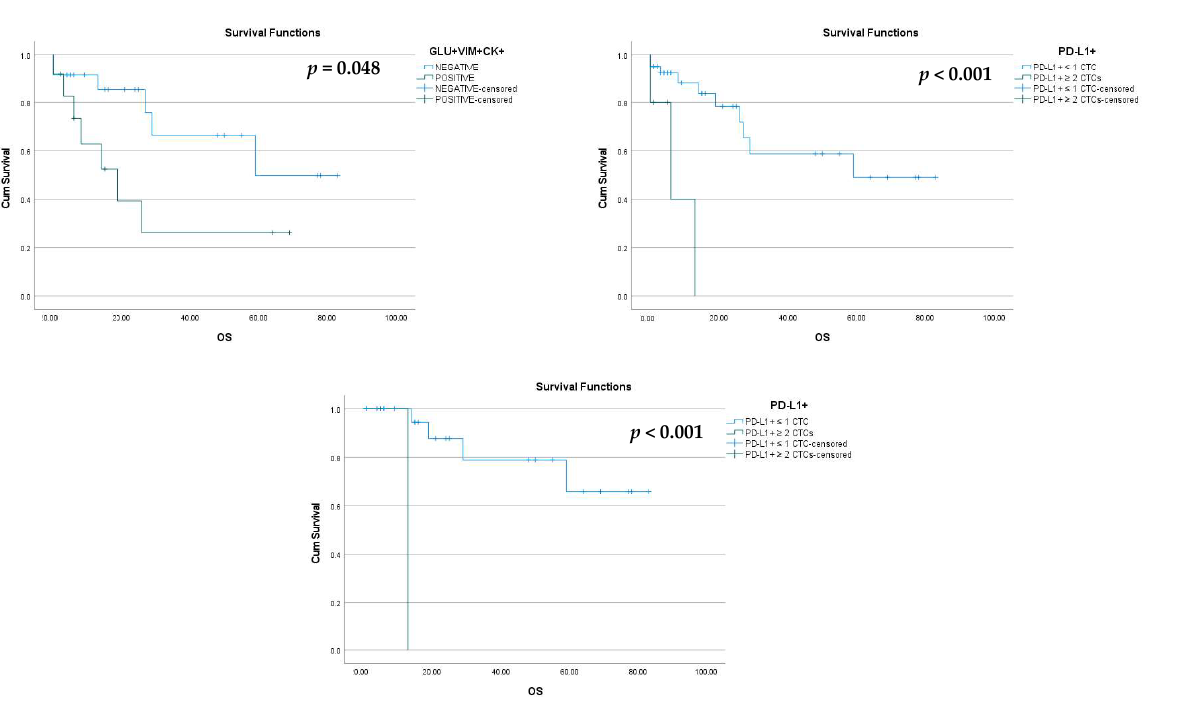
Figure 6. Estimate of OS of TNBC patients with respect to the expression of GLU, VIM, and PD- L1. ( A ) Kaplan–Meier survival curve for TNBC patients positive for GLU + VIM + CK + phenotype ( p = 0.048). ( B ) Kaplan–Meier survival curve for TNBC patients with two or more PD-L1+ CTCs compared to TNBC patients with one or no CTCs ( p < 0.001). ( C ) Kaplan–Meier survival curve for early TNBC patients with two or more PD-L1+ CTCs compared to early TNBC patients with one or no CTCs ( p <